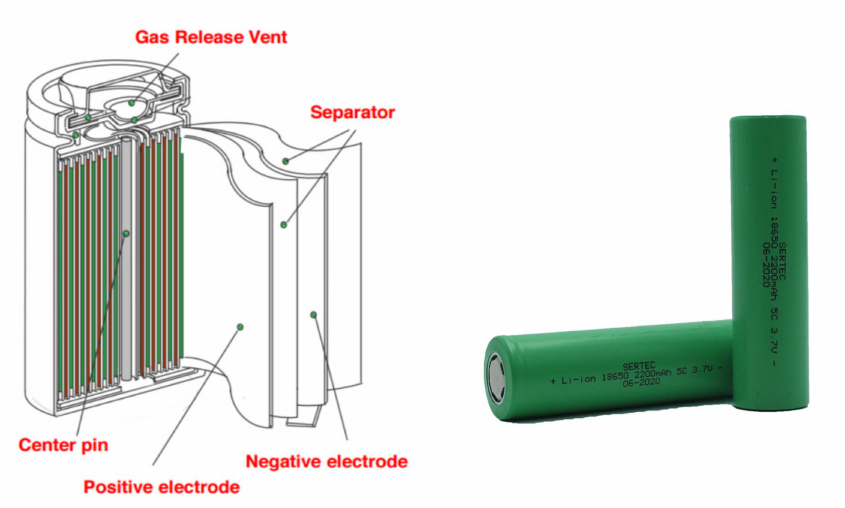
Figure 12. 18,650 LCO type lithium-ion battery used in Exp. B